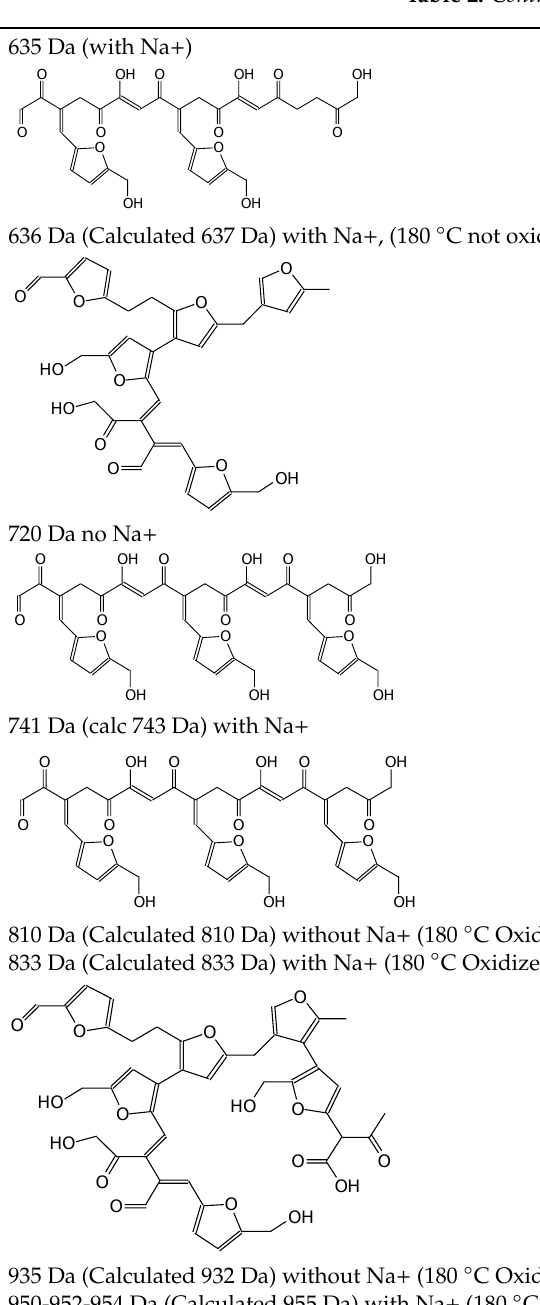
O H OO O H OO H OOOO OOOO H OOOO H H H 635 Da (with Na + ) 635 Da (with Na+) 635 Da (with Na+) 635 Da (with Na+) OO O H OO O H OO O H OO O H OO O H OO O H OO O H OO O H OO O H